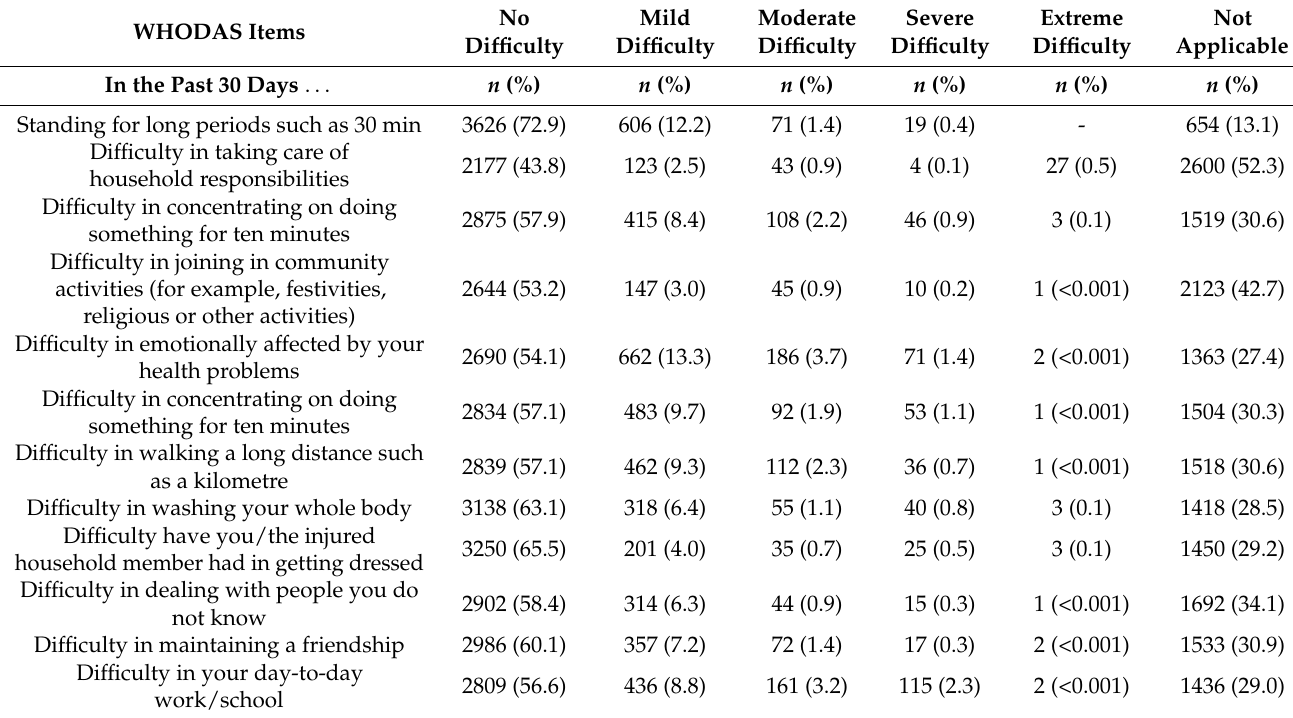
Table 4. Frequency by 12 domains of WHODAS, post the most recent non-fatal drowning event. WHODAS Items In the Past 30 Days . . .